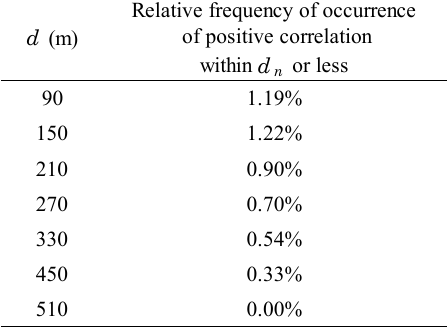
Table 2 . Relative frequency of the occurrence of positive correlation within d n or less in Kagawa, 2015